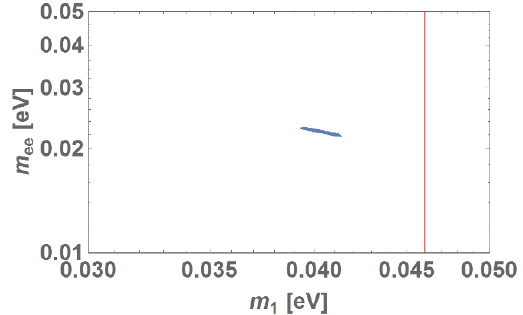
Figure 3 . The prediction of Majorana phases (cid:11) 21 and (cid:11) 31 for NH in model I(a).